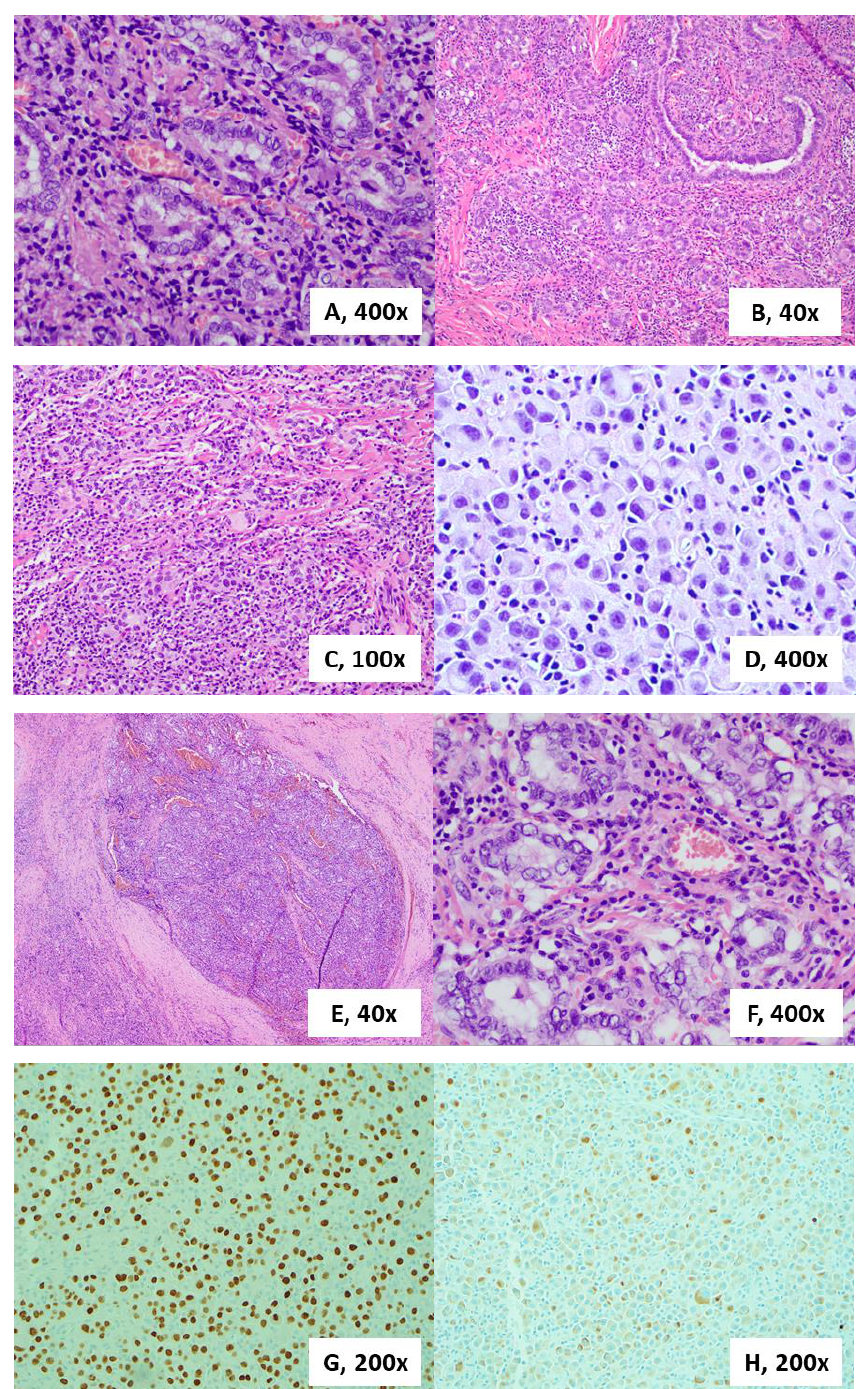
Figure 2. Histologic sections of the left thyroid lobe showing areas of papillary thyroid carcinoma ( A ), H&E 400 × ; with a transitional morphology to microfollicular, solid sheet and plasmacytic pattern of growth ( B ), H&E 40 × ; at a lower magnification showing sheets of plasmacytic cellularity ( C ), H&E 100 × ; and at a higher magnification showing binucleated cells with mature plasma cell features ( D ), H&E 400 × . Histologic sections of the supraclavicular mass showing a lymph node with metastatic papillary thyroid carcinoma ( E ), H&E 40 × ; and a higher magnification showing a solid, undi ff erentiated component ( F ), H&E 400 × . Positive immunohistochemical staining for TTF-1, 200 × ( G ) and PAX-8, 200 × ( H ) on sections of the left thyroid